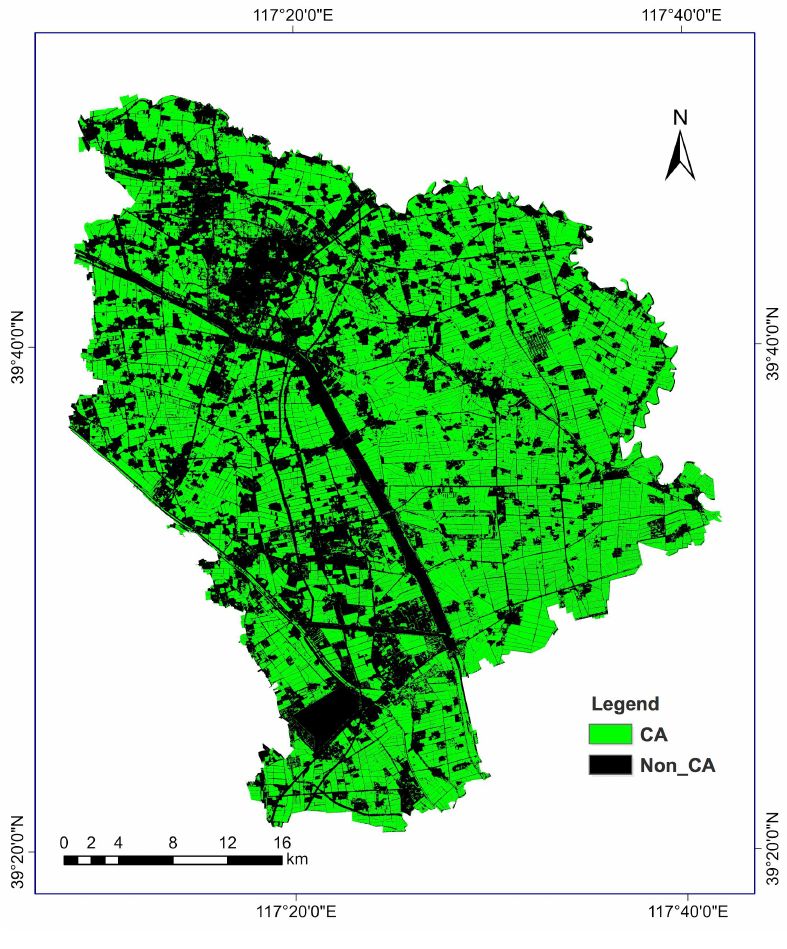
Figure 5. Classification results in Baodi with DeepLabv3 + . Table 2. Accuracy assessment of DeepLabv3 +